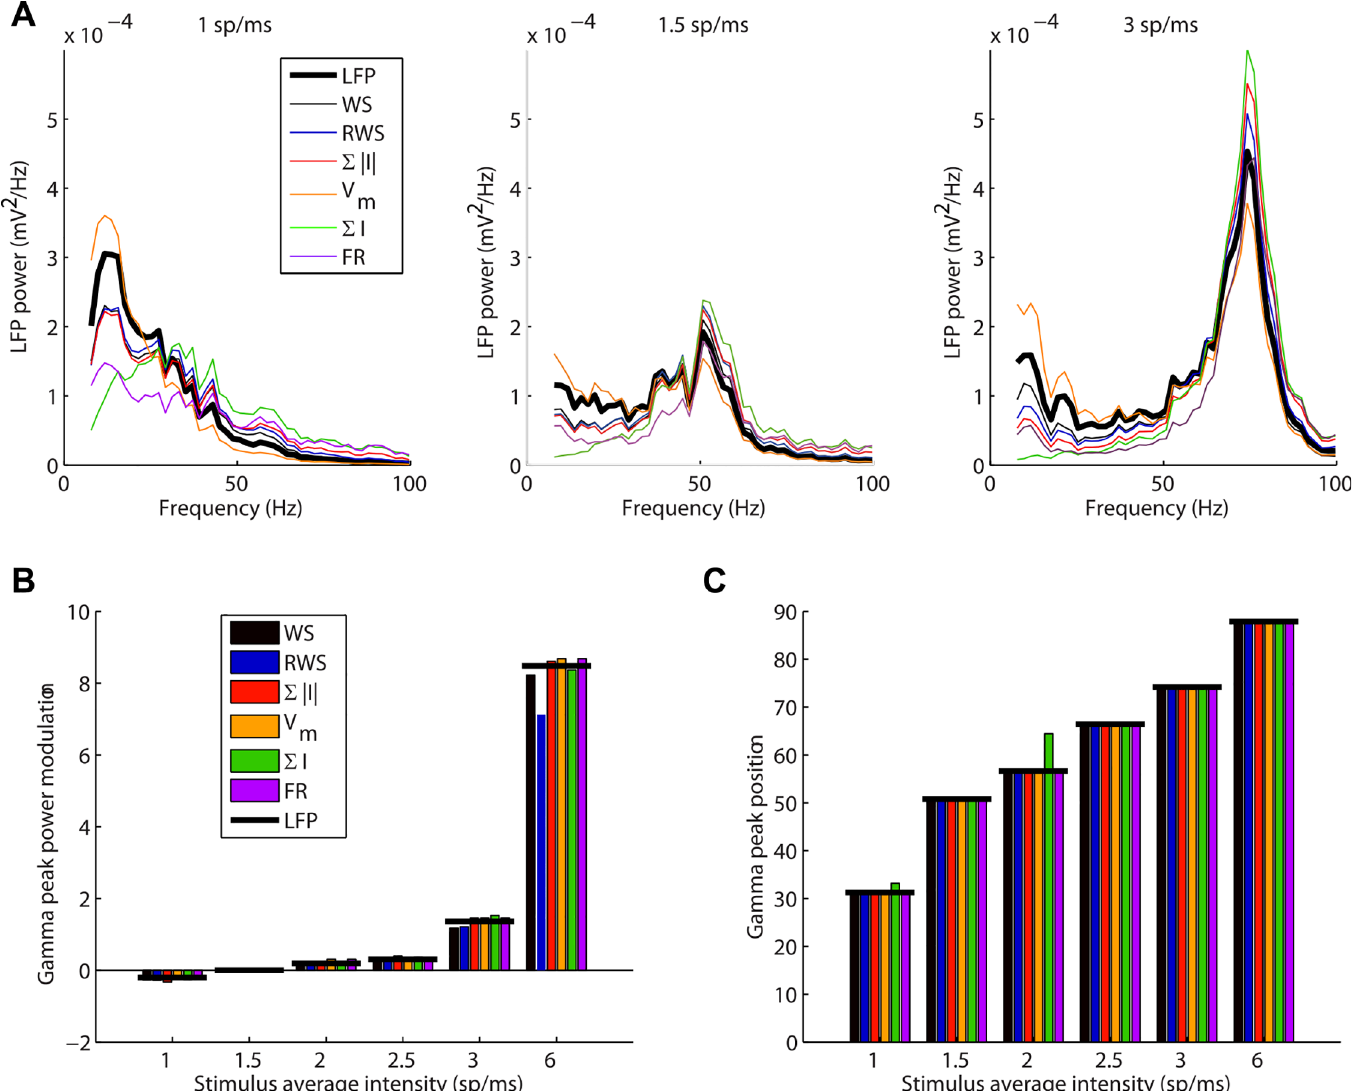
Fig 7. Spectral analysis of LFP signal. (A) Power spectra of the LFP signal at recorded at the 100 μ m depth position, and predictions from candidate LFP proxies for input stimulation frequencies of 1 spikes/ms (left), 1.5 spikes/ms (center), 3 spikes/ms (right). Similar results are found for recordings at all depths. Note that for low inputs the power decreased almost monotonously with frequency, while for sufficiently strong input, LFP gamma fluctuations appeared and increased in power and frequency with stimulus intensity. (B) Variation of gamma (30 – 100 Hz) peak power with stimulus input intensity for the LFP signal and all proxies (measured as relative increase compared to the power at 1.5 spikes/ms). (C) Gamma peak frequency as a function of input frequency for the LFP signal and all